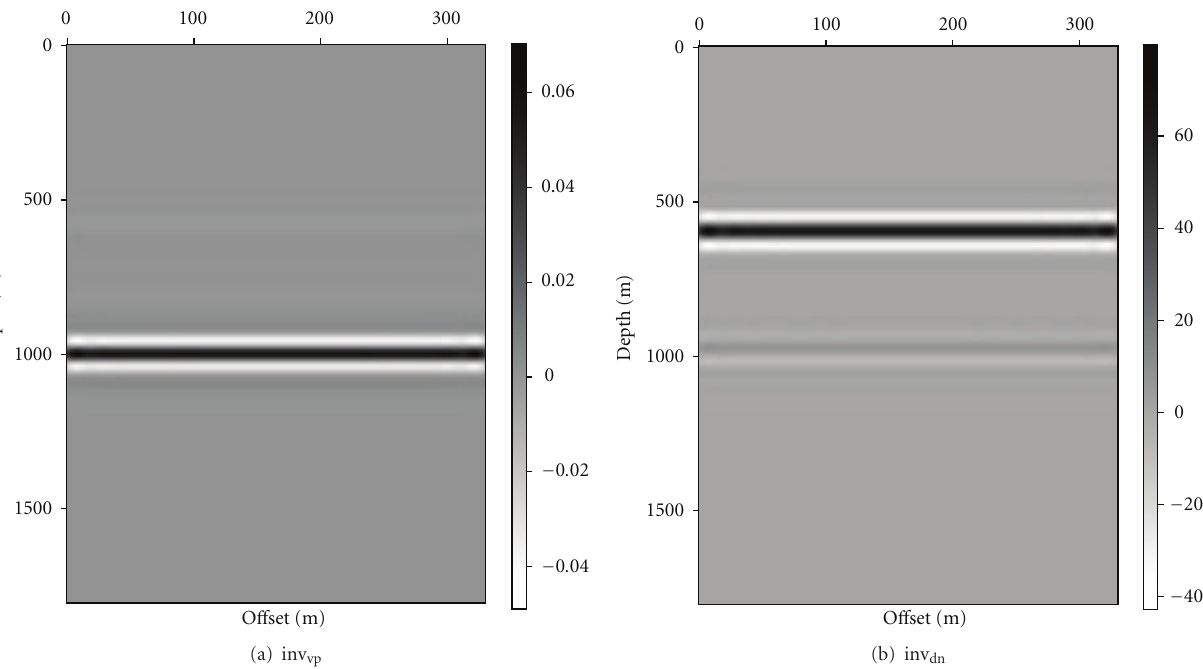
Figure 6: The approximate inverse. The contributions from velocity and density are separated, and the amplitudes are corrected.